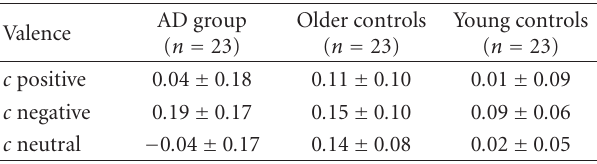
Table 3: Response criterion values ( c ) and standard errors for pos- itive, negative and neutral pictures in the AD and control